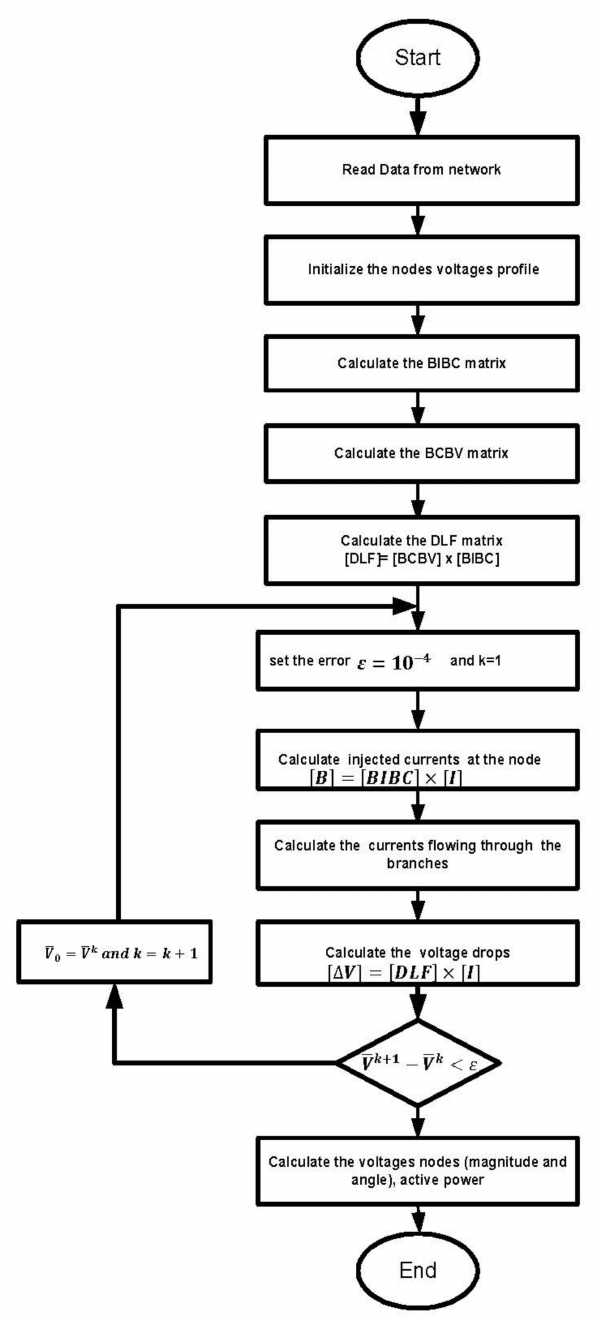
Figure 1. Flowchart of the proposed load